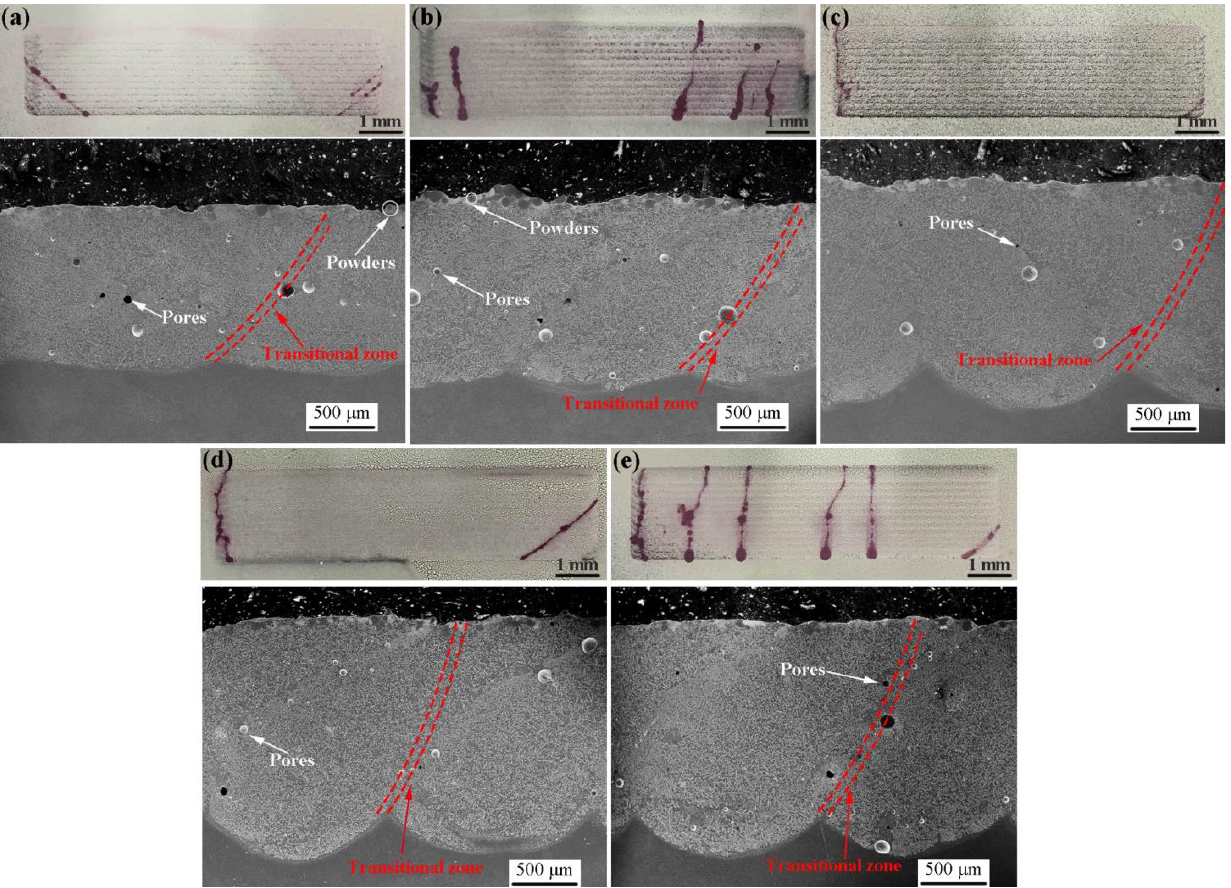
Figure 2. Surface and cross-sectional SEM macrographs of various coatings: ( a ) without CeO 2 ; ( b ) 1 wt.% CeO 2 ; ( c ) 2 wt.% CeO 2 ; ( d ) 3 wt.% CeO 2 ; ( e ) 4 wt.% CeO 2 .